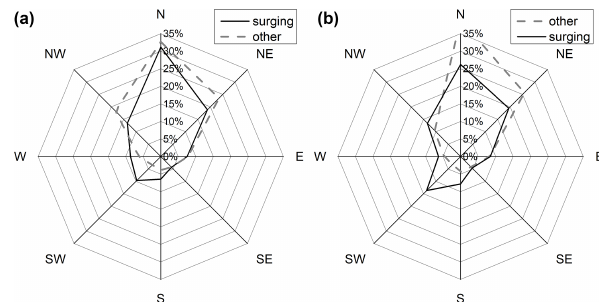
Figure 8. Aspect sector distribution for surging and other glaciers (in relative terms) per (a) count and (b) area covered.